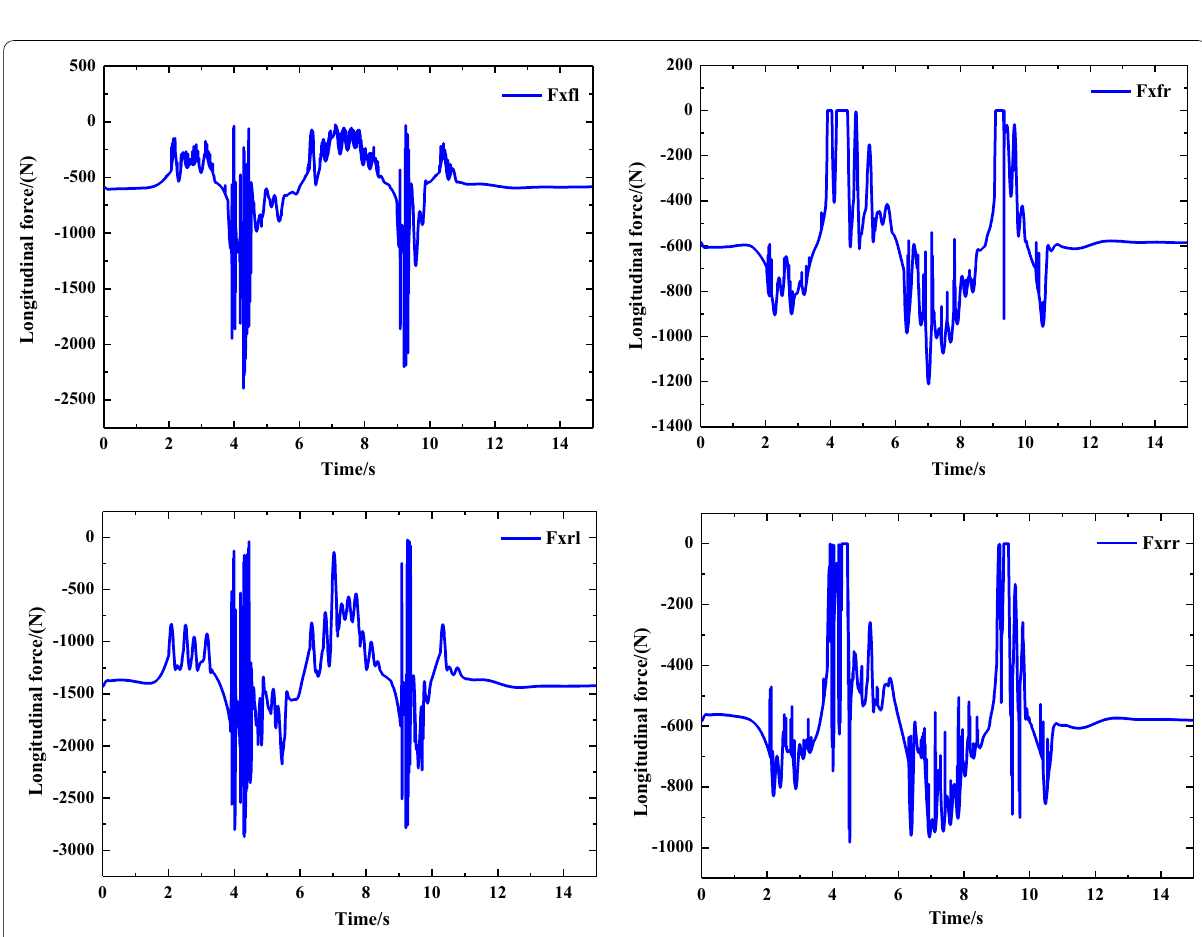
Figure 8 Tire forces allocation results based on the robust least-squares control allocation method ( μ